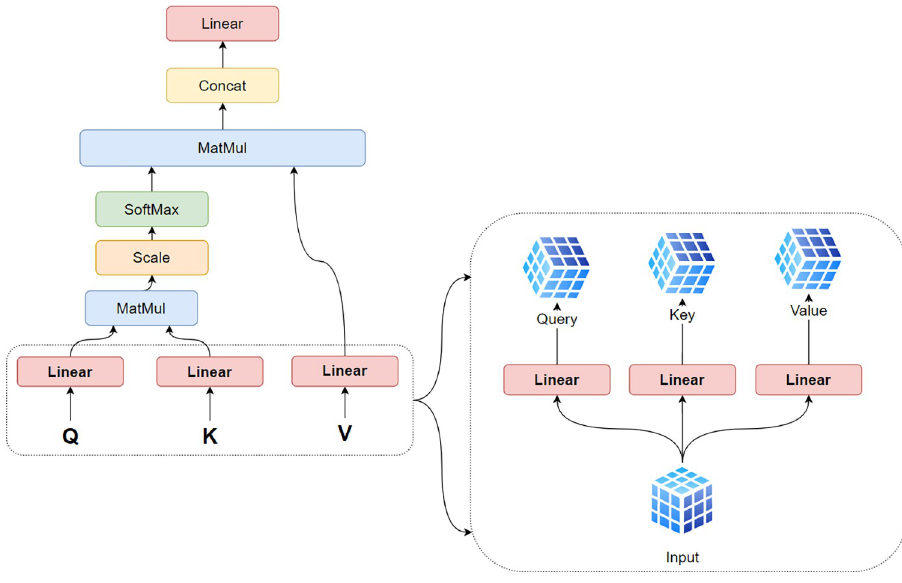
Fig 2. Multi-headed